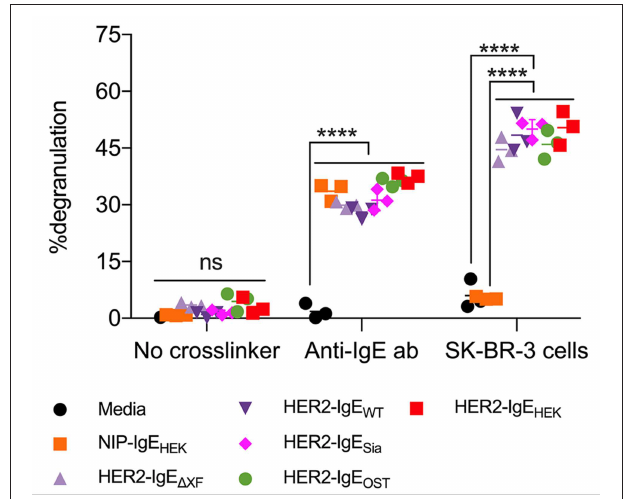
FIGURE 4 | HER2-IgE stimulation of mast cells. IgE-mediated degranulation of RBL-SX38 mast cells measured in negative control (no crosslinker), positive control (polyclonal anti-IgE antibody), and using a HER2-expressing tumor cell line to trigger cross-linking of HER2-IgE-Fc ε RI complexes. N = 3, error bars show the standard deviation. **** P < 0.0001; ns, not significant. Data representative of two independent experiments. Isotype NIP-IgE expressed in Expi293F cells (IgE-NIP HEK ) was used as a